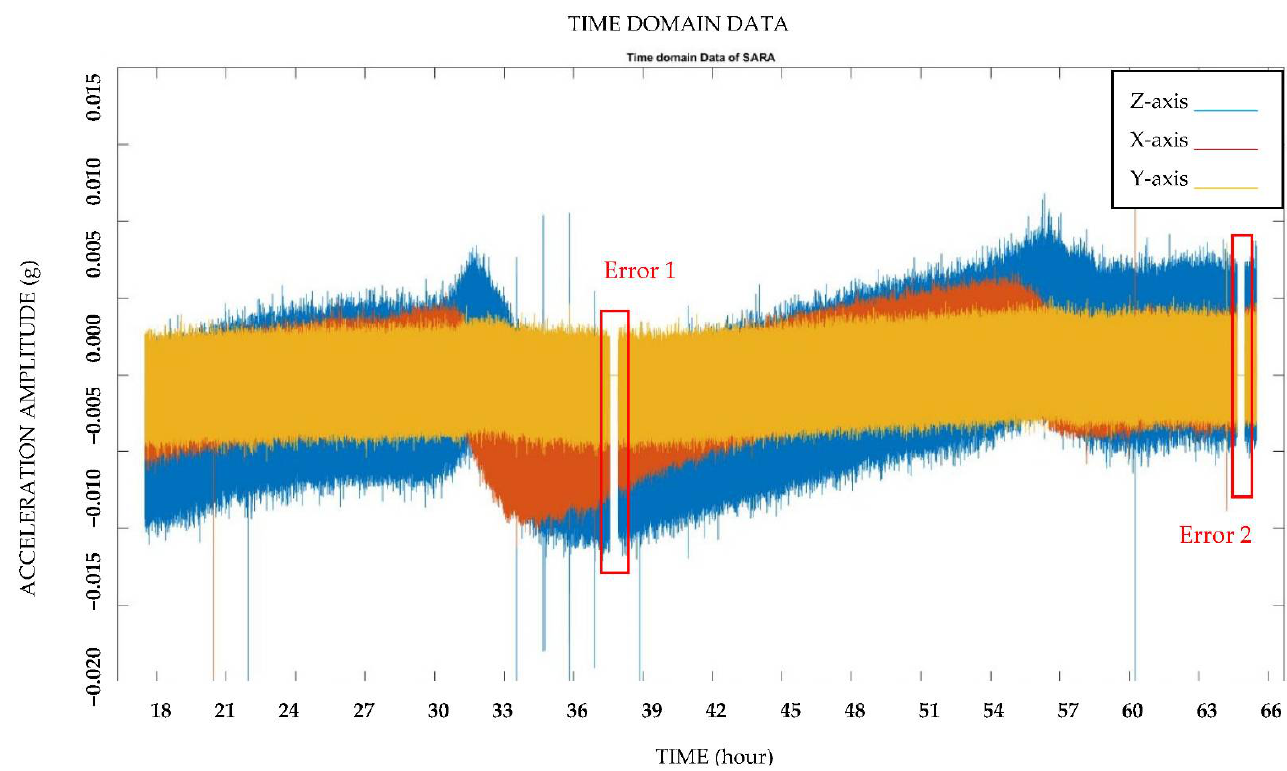
Figure 13. Acceleration amplitude records from SARA.